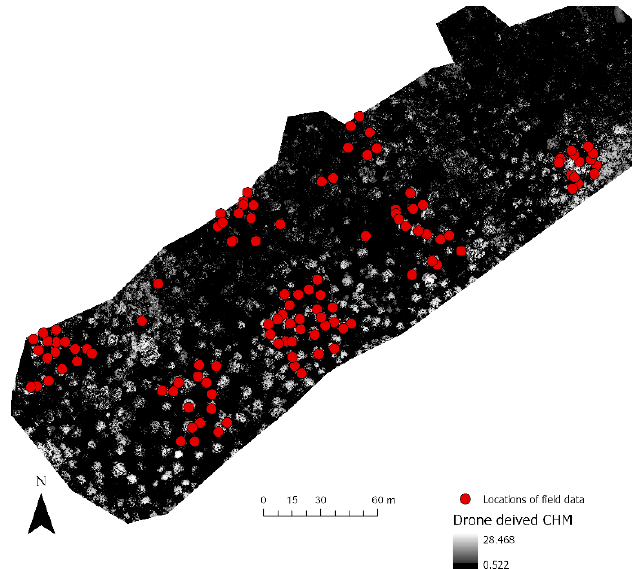
Figure 11. Location of field-measured tree height data points.